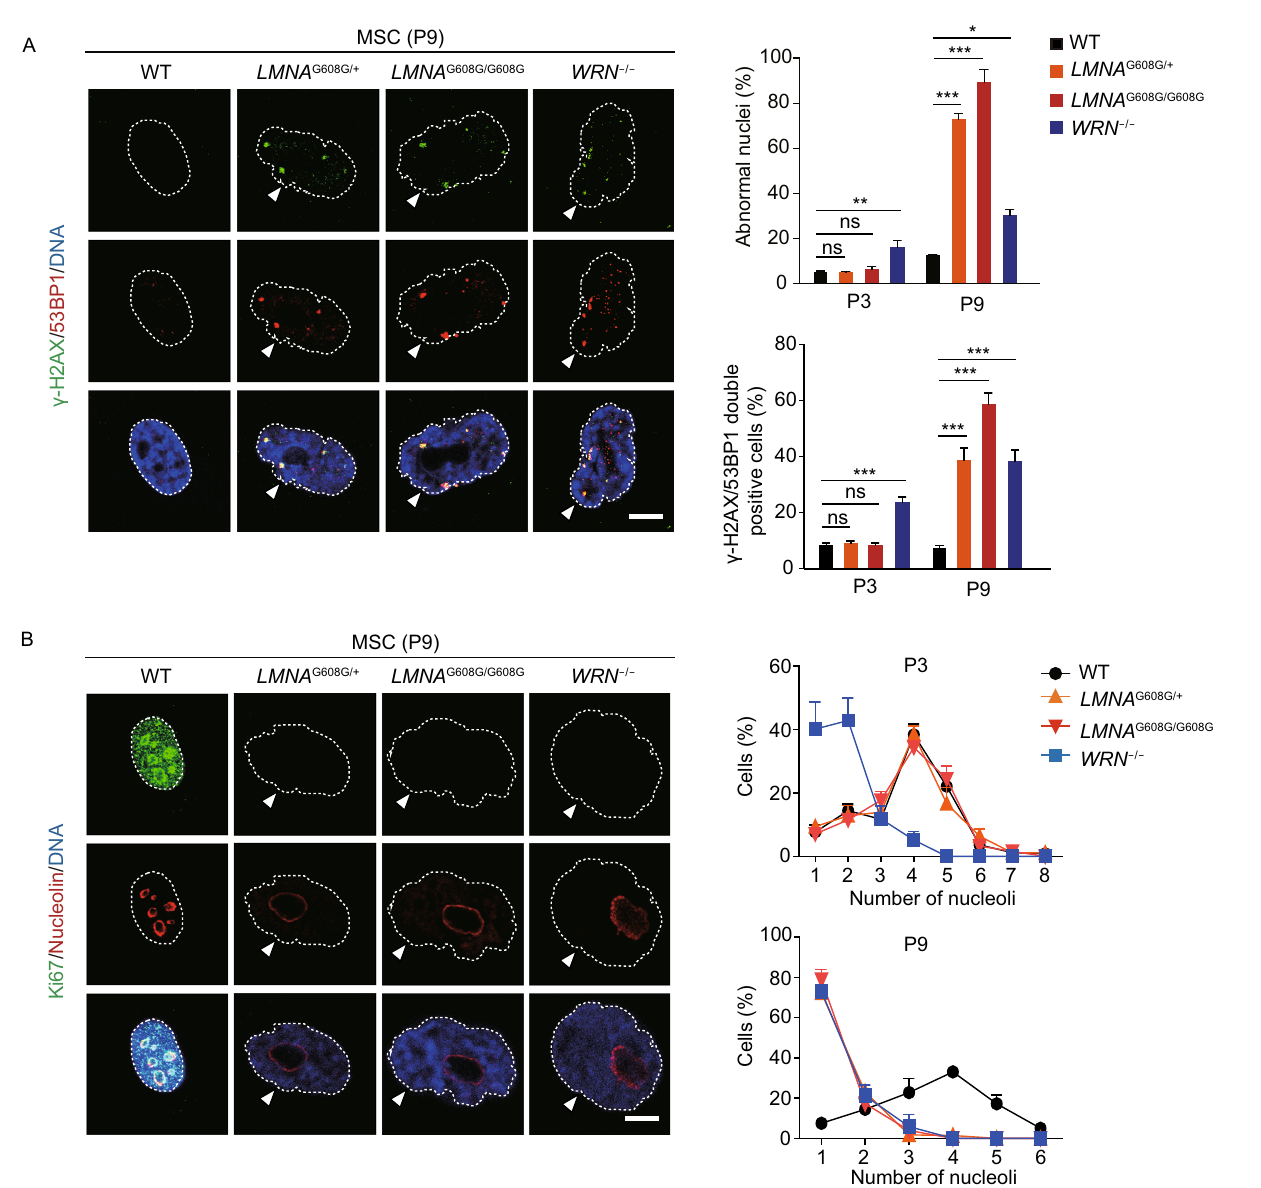
Figure 6. Immuno fl uorescence analysis of DNA damage response and nucleolar changes in HGPS-MSCs and WS-MSCs. (A) Left: representative immunostaining of γ -H2AX and 53BP1 in WT, heterozygous ( LMNA G608G/+ ), homozygous ( LMNA G608G/G608G ) and WRN − / − MSCs. Dashed lines indicate the nuclear boundaries and white arrows indicate abnormal nuclei. Scale bar, 10 μ m. Right: percentages of cells with aberrant nuclear architecture (upper) and γ -H2AX/53BP1 double-positive cells (lower) were shown as mean ± SEM, number of cells ≥ 300. *** P < 0.001; ** P < 0.01; * P < 0.05; ns, not signi fi cant. (B) Left: representative immunostaining of Ki67 and nucleolin in WT, heterozygous ( LMNA G608G/+ ), homozygous ( LMNA G608G/G608G ) and WRN − / − MSCs. Dashed lines indicate the nuclear boundaries and white arrows indicate abnormal nuclei. Scale bar, 10 μ m. Right: percentages of cells with different numbers of nucleoli were shown as mean ± SEM, number of cells ≥ 300. Upper, passage 3; lower, passage